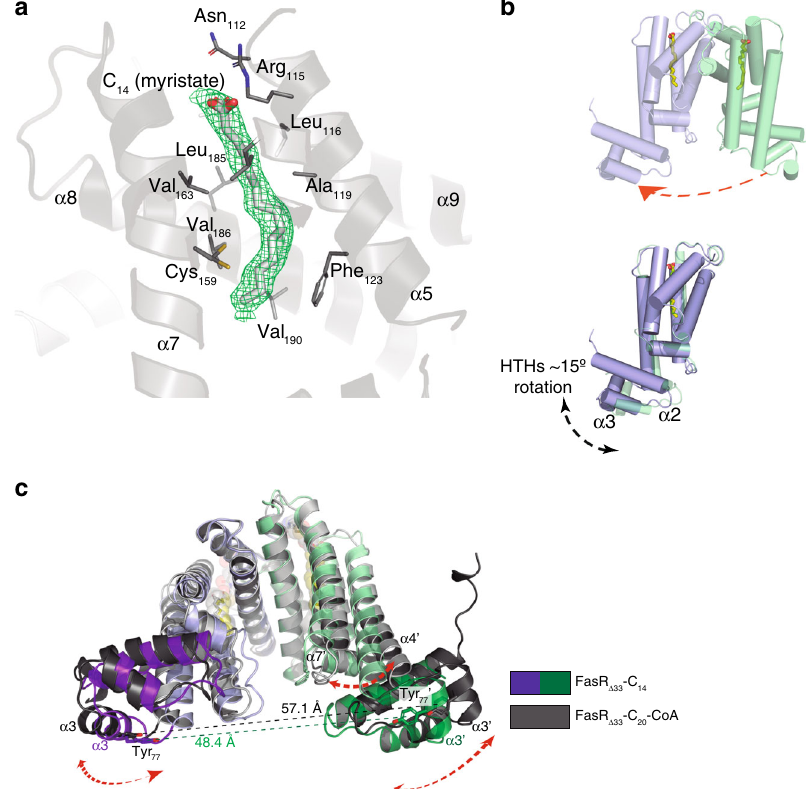
Fig. 2 FasR Δ 33 -C 14 exhibits larger protein fl exibility including dimer asymmetry. a SigmaA-weighted mF obs -DF calc difference Fourier map contoured at 3.5 σ (green mesh) calculated with no ligand bound in the effector-binding tunnel during FasR Δ 33 -C 14 re fi nement. The FasR Δ 33 -C 14 model is shown with grey cartoons, and residues at ≤ 4 Å from the ligand are depicted with thin sticks. The electron density allowed to model a myristic acid, overlaid within the difference map in thick sticks coloured by atom. Note polar and charged residues on the top opening, close to the carboxyl head of the ligand. Hydrophobic residues line up the rest of the tunnel ’ s walls. b FasR Δ 33 -C 14 protomers A and B are coloured as in Fig. 1. The dimer is asymmetric, quantitated by superimposing protomer B onto A (red arrow in the top panel), after what the effector-binding domains fi t quite well while the HTH domains show signi fi cant rotation between one another (bottom panel), with max root-mean-square deviation (rmsd) on helices α 2 and α 3. c The FasR Δ 33 -C 20 -CoA and FasR Δ 33 -C 14 structures are superposed, resulting in maximal fi t on the central 4-helix bundle that mediates dimerisation (helices α 8 – α 9 from both protomers). The upper portion of the effector-binding domains end up well aligned, but signi fi cant shifts affect the lower part together and the HTH domains (dashed arrows). The distance between the centres of mass of Tyr 77 on helix α 3, differs by more than 10 Å between both structures. The HTH domains move consolidated with the bottom portion of juxtaposed helices α 4 and α 7 from the effector-binding FasR Δ 33 -C 14 . Using the position of conserved Tyr 77 C α as a reference (at the centre of helix α 3, key to mediate DNA-binding), the two HTH domains in FasR Δ 33 -C 14 are ~48 Å apart, vs ~57 Å